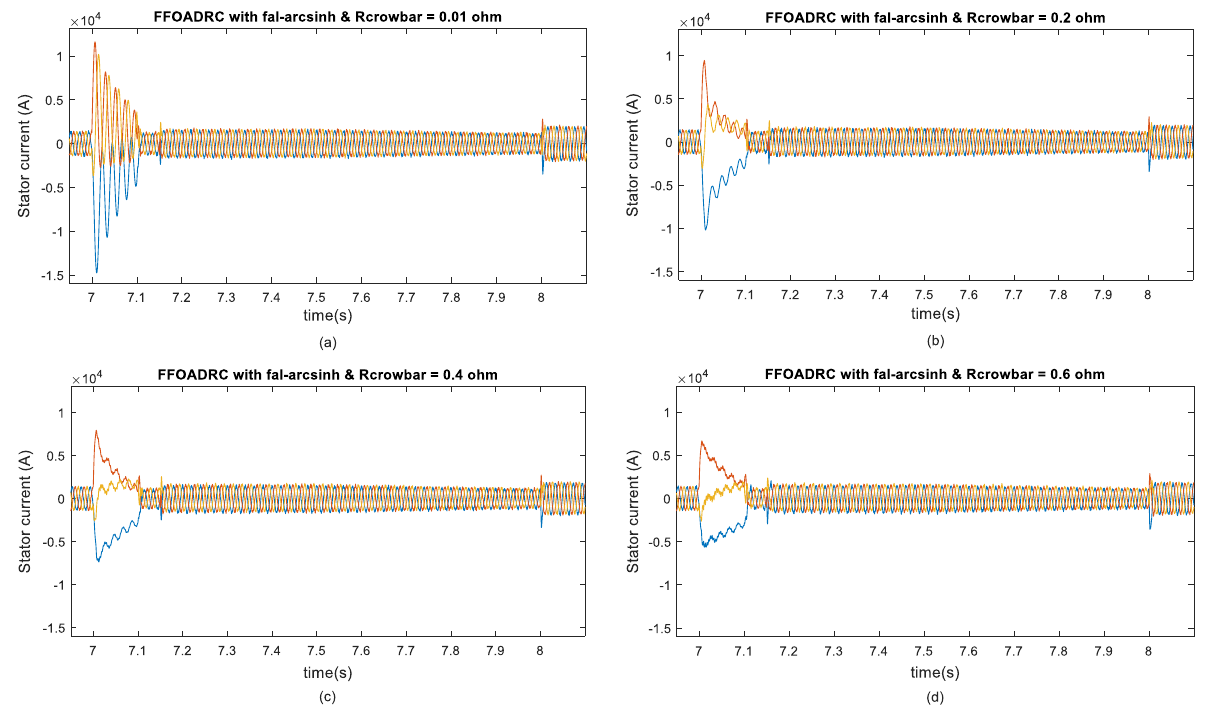
Fig. 22 Stator current of the DFIG during symmetrical voltage sag for different values of R crowbar . ( a ) R crowbar R crowbar 0.4 ohm, and ( d ) R crowbar =